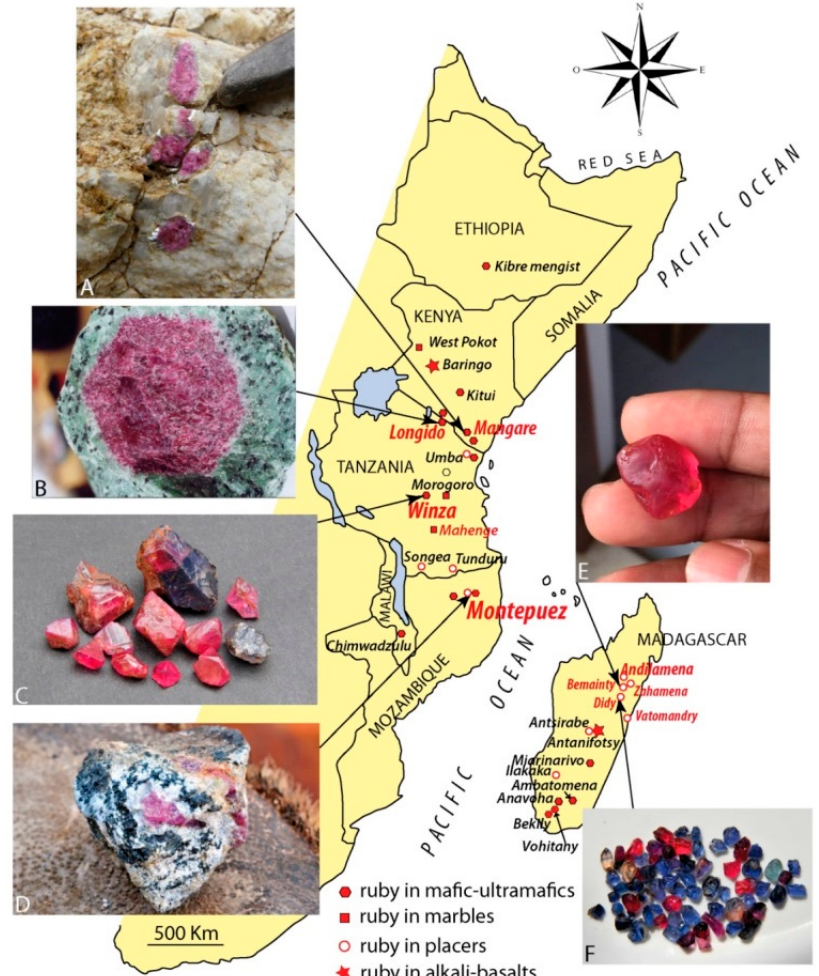
Figure 4. In East Africa and Madagascar rubies have been and are produced from both primary and secondary deposits. The most important deposits are those located in the Neoproterozoic Metamorphic Mozambique Belt. Of much lesser importance are deposits in which the ruby is entrained as xenocrysts in Cenozoic alkali basalts; these are the Baringo and Antanifotsy (Soamiakatra) deposits in Kenya and Madagascar, respectively. ( A ) Desilicated pegmatite in ultramafic rocks of the Rockland (ex-John Saul) mine in the Mangare area. Photo width 7 cm. Photo: Gaston Giuliani; ( B ) a ruby hexagonal prism (5 cm across) in anyolite rock (with green zoisite and black amphibole) from Longido, Tanzania. Photo: Gaston Giuliani; ( C ) rubies and two colored sapphires (3 cm across) from the Winza deposit in Tanzania, which occurs in metamorphosed leucogabbro and amphibolite. Photo: Vincent Pardieu; ( D ) ruby (5 cm long) in metasomatized amphibolite at M’sawize. Photo: Vincent Pardieu © GIA; ( E ) pink corundum (1 cm across) from placer at Bemainty, Madagascar. Photo: Vincent Pardieu © GIA; and ( F ) ruby and sapphires recovered from placer at Didy, Madagascar. Photo: Vincent Pardieu.